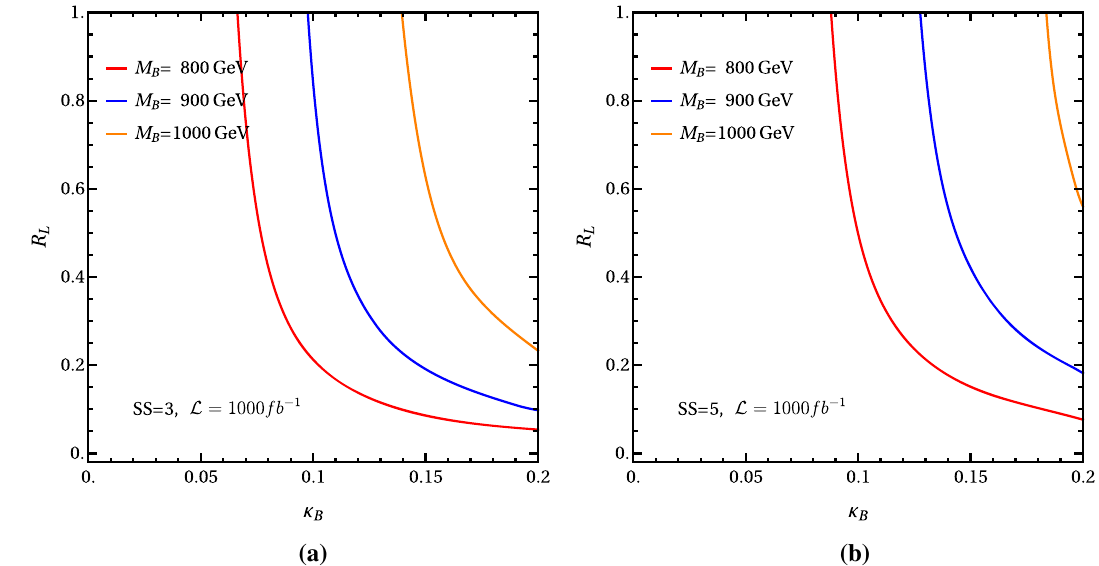
− κ plane with three typical VLQ-B masses at the LHeC with the integrated luminosity of L B